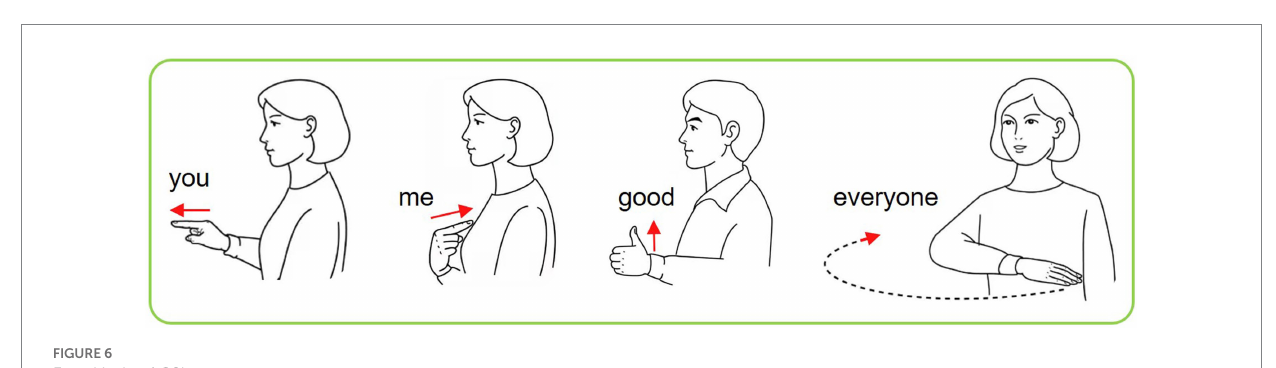
FIGURE 6 Four kinds of CSL